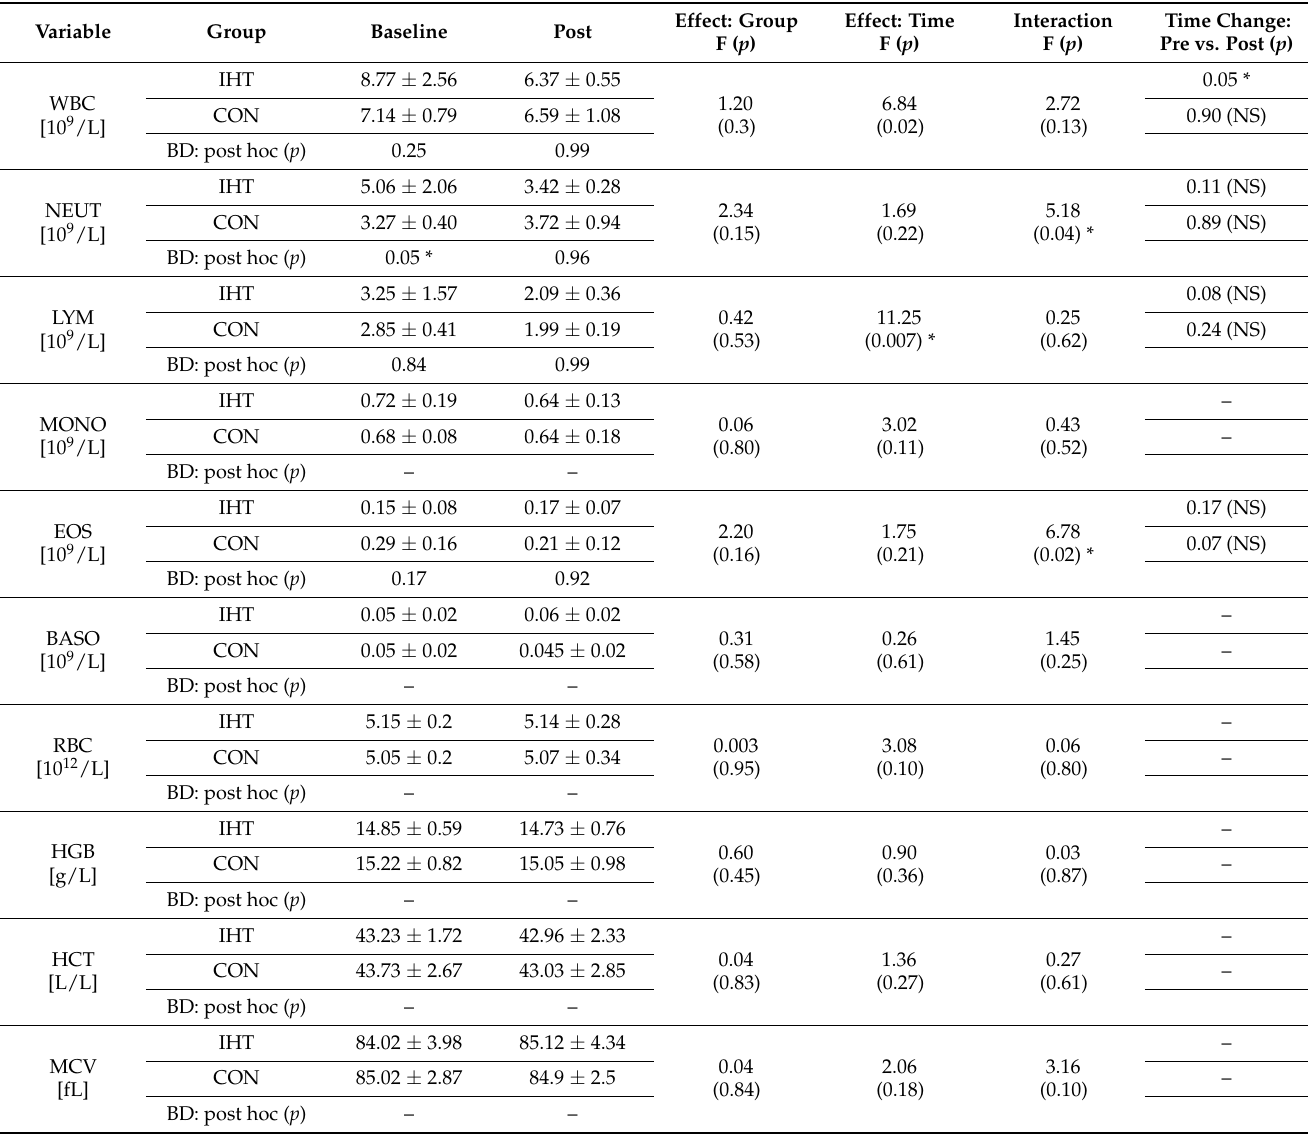
Table 3. Mean values ( ± SD) of blood morphology indicators in rowers training in the hypoxia and normoxia (control) conditions before and after the